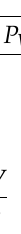
Figure 4. Multiple ‐ jet cavitation device.